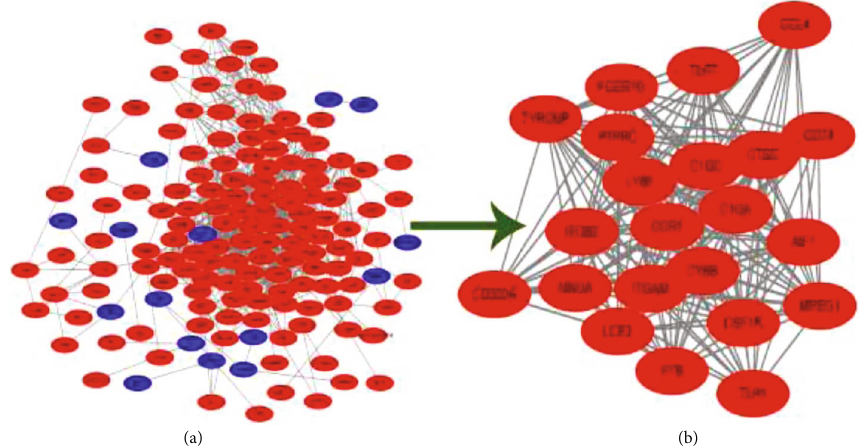
Figure 3: (a) Cytoscape was used to design DEGs ’ PPI network. (b) PPI network with 22 nodes and 202 edges yielded the most signi fi cant module. The genes that were upregulated are labeled in red. The downregulated genes are labeled in